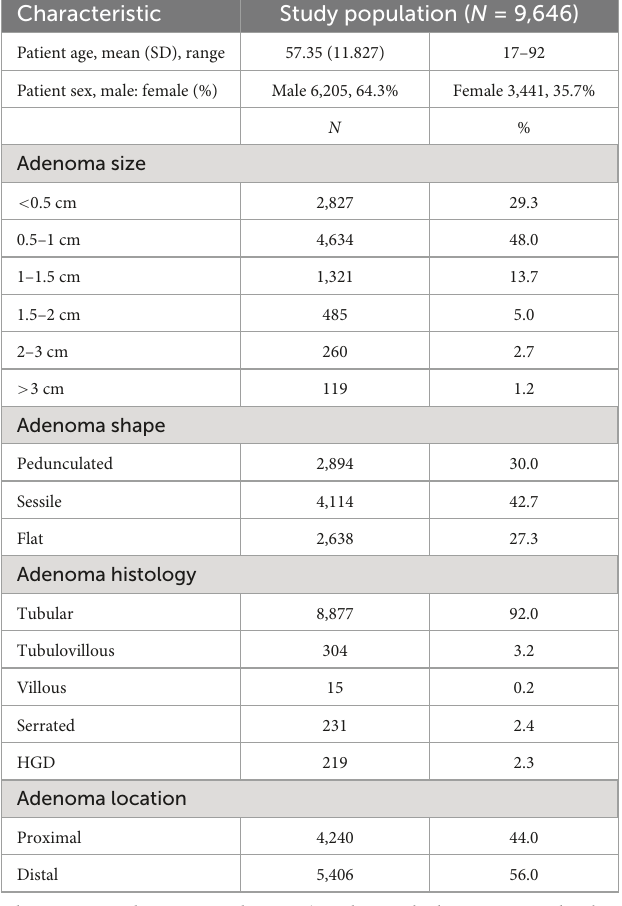
TABLE 1 Basic characteristics of patient and polyp. TABLE 2 Univariate analysis of adenoma factors relative to the occurrence of HGD.